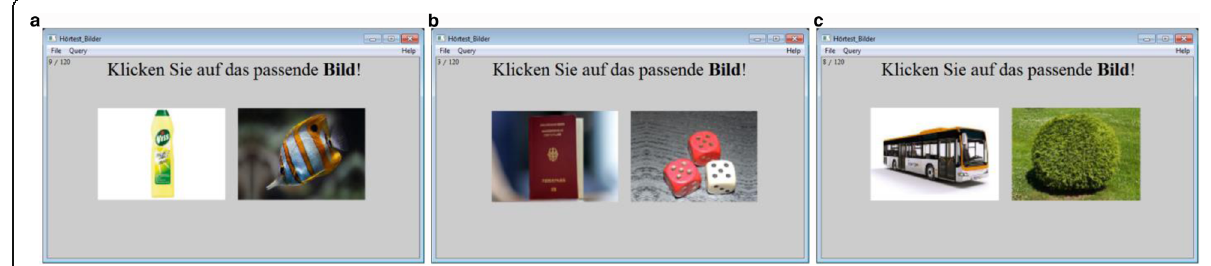
Fig. 6 Original screenshots of the three types of response displays presented to the listeners in the main experiment. Listeners identified the stimulus- final target words by clicking on the pictures for Viss or Fish ( a ), Pass or Pasch ( b ), or Bus or Busch ( c